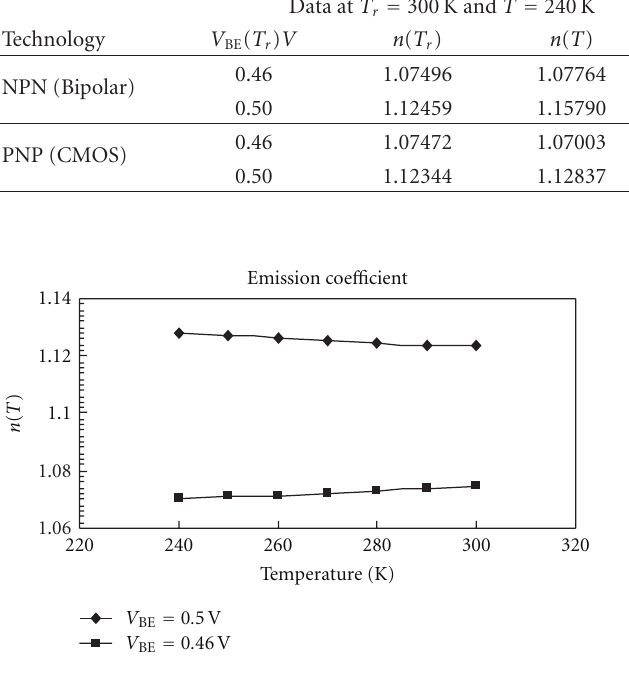
Figure 6: Variation of n ( T ) for vertical PNP transistors in 0.5 μ m CMOS technology with η = 5 . 1, V G 0 = 1 . 12046